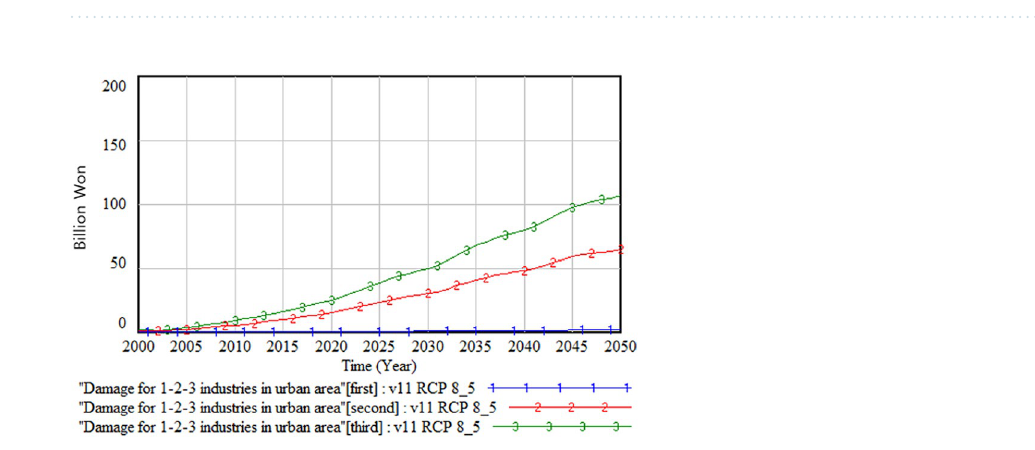
Figure 6. Damage cost in urban and rural areas.